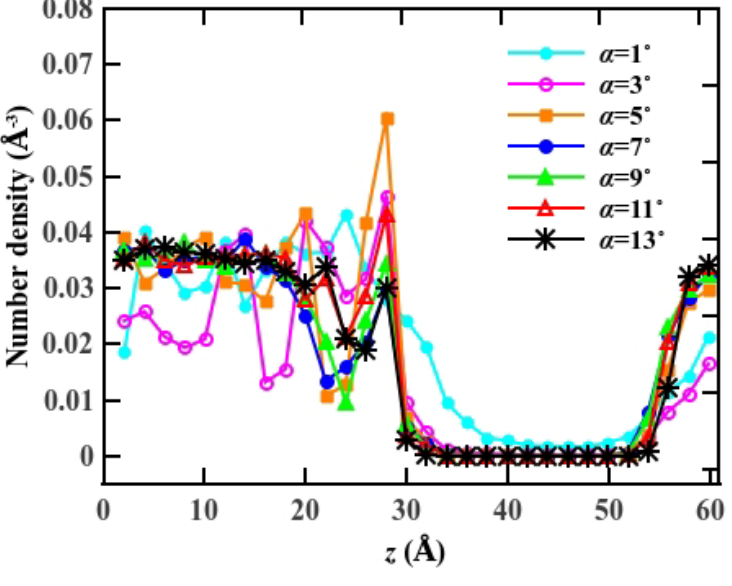
Figure 2. The number density distribution of water molecules inside the pore along the axial direction for p = 10.03 katm. The center of the pore is located at z = 30 Å.